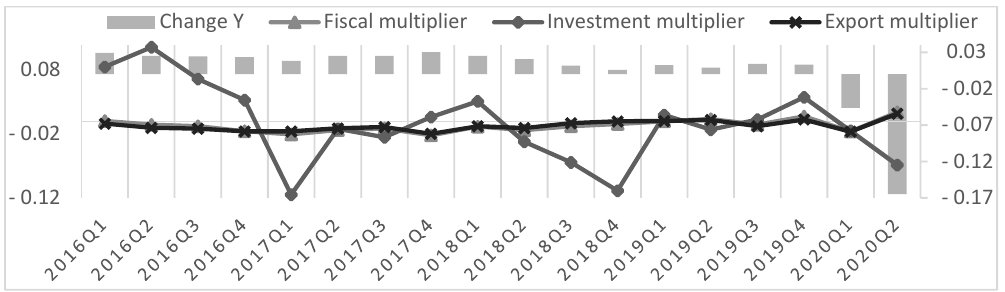
Figure 12. Changes in autonomous expenditure multipliers and GDP—Italy, own work, source: Eurostat.